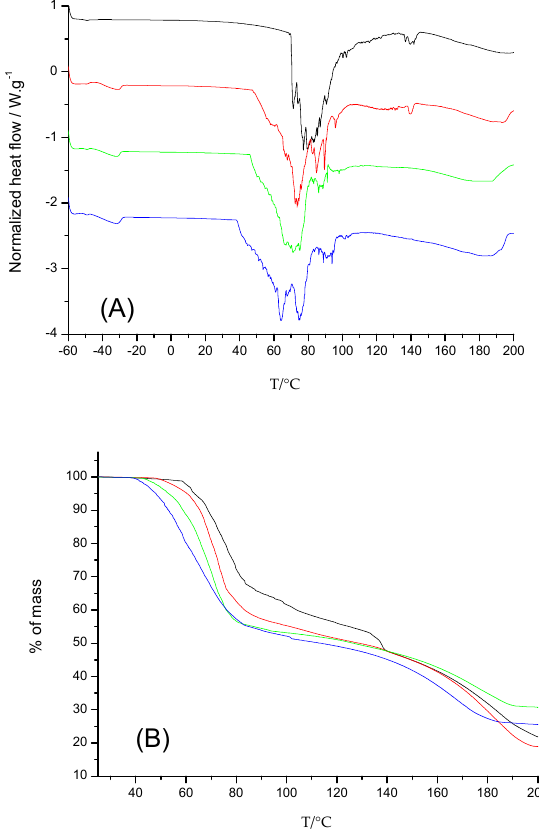
Figure 2. DSC ( A ) and TGA ( B ) curves obtained for PFH based emulsions prepared with 0.5 (black), 1 (red), 2 (green), and 3% (blue) of Zonyl ® .